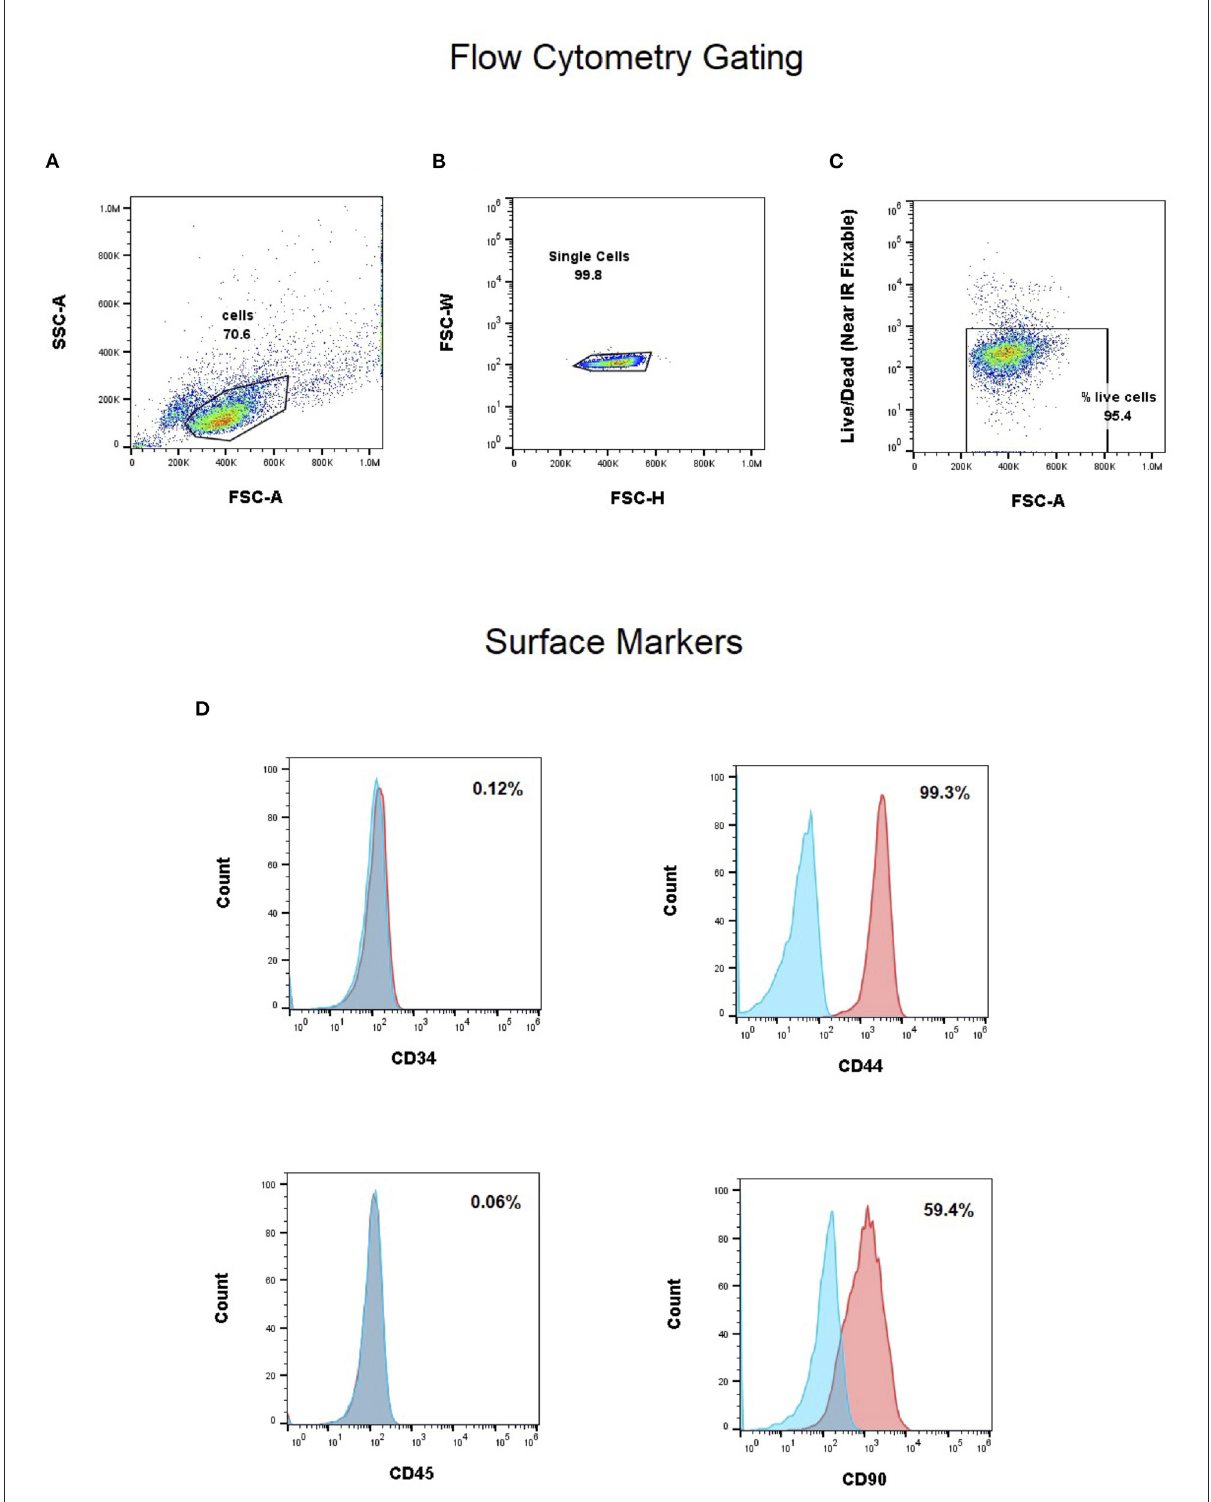
FIGURE1 (A–C) Gating strategy for single cell and live cells. Flow cytometry analysis for single-color expression frequencies for CD34, CD45, CD44 and CD90 (D) . CD34 and CD45 markers have expression frequencies well below 1%, while CD44 has an expression level exceeding 99%. CD90 marker expression is strongly positive at